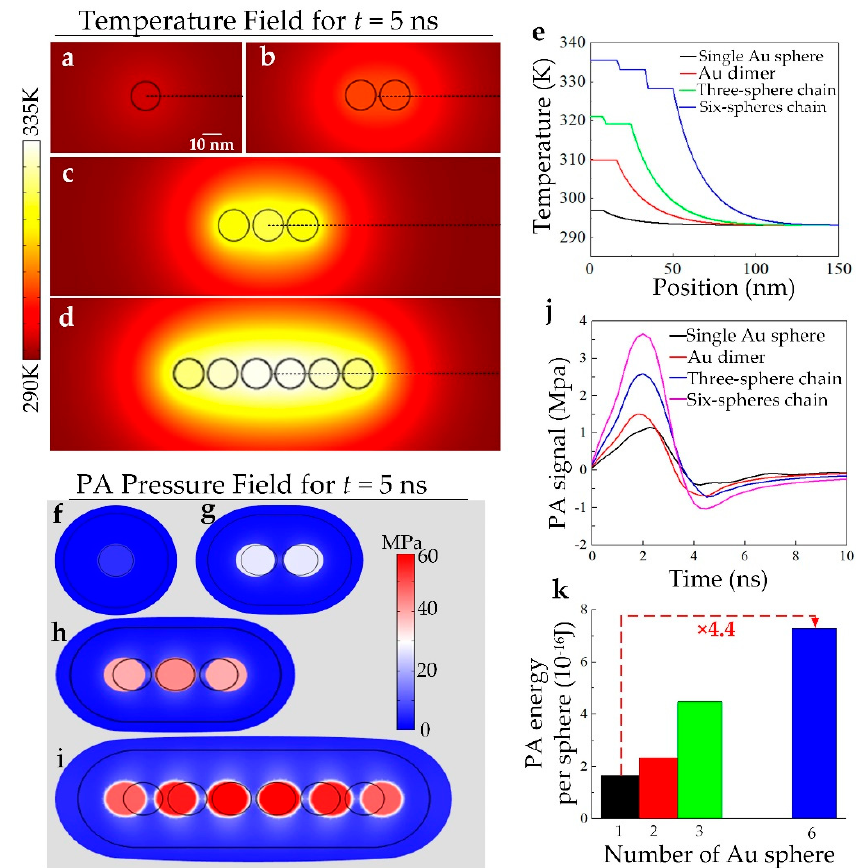
Figure 3. Quantitative thermal fields and PA e ff ect of the GNCs for di ff erent chain lengths when irradiated by a laser pulse with an irradiance of 0.15 mW / µ m 2 . ( a – d ) The thermal fields of the GNCs for di ff erent chain lengths at t = 5 ns; ( e ) Temperature distribution along the dotted lines in (a–d); ( f – i ) The thermal expansion induced stress of the GNCs and surroundings at t = 5 ns; ( j ) The corresponding produced PA signals for GNCs with di ff erent chain lengths; ( k ) Quantitative calculation of the per-sphere-weighted PA energy for GNCs with di ff erent chain